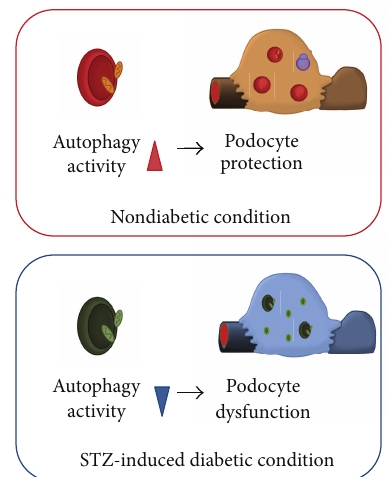
Figure 3: Autophagy in podocytes under diabetic conditions. Podocytes show high rates of autophagy even under nonstress conditions (upper panel). Autophagy activity is altered in podocytes under streptozotocin-induced type 1 diabetic conditions (lower panel). These results suggest that hyperglycemia alters autophagic activity, which may contribute to diabetes-related podocyte